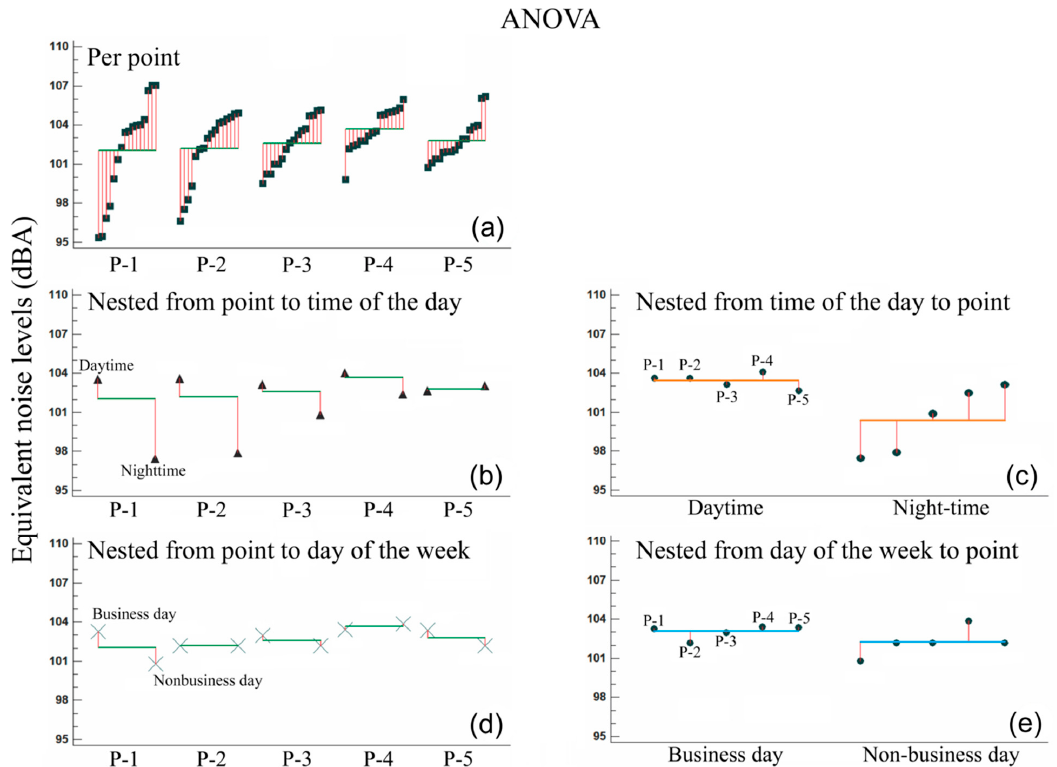
Figure 6. ANOVA graphs for the equivalent noise level with different nested sampling factors (P. sampling point). ( a ) The environmental noise ANOVA test. ( b ) ANOVA nested from sampling points to time of the day for noise level values. ( c ) ANOVA nested from the time of day to sampling points for noise level values. ( d ) ANOVA nested from sampling points to the day of the week for noise level values. ( e ) ANOVA nested from the day of the week to sampling points for noise level values. The hourly mean of LA eq is represented by (cid:4) , (cid:78) represents the mean of LA eq per time of the day, • represents the mean of LA eq per sampling point, and represents the mean of LA eq per type of day of the week. The green line is the mean of LA eq . The orange line is the mean of five sampling points for day or night. The blue line is the mean of five sampling points for each type of day.